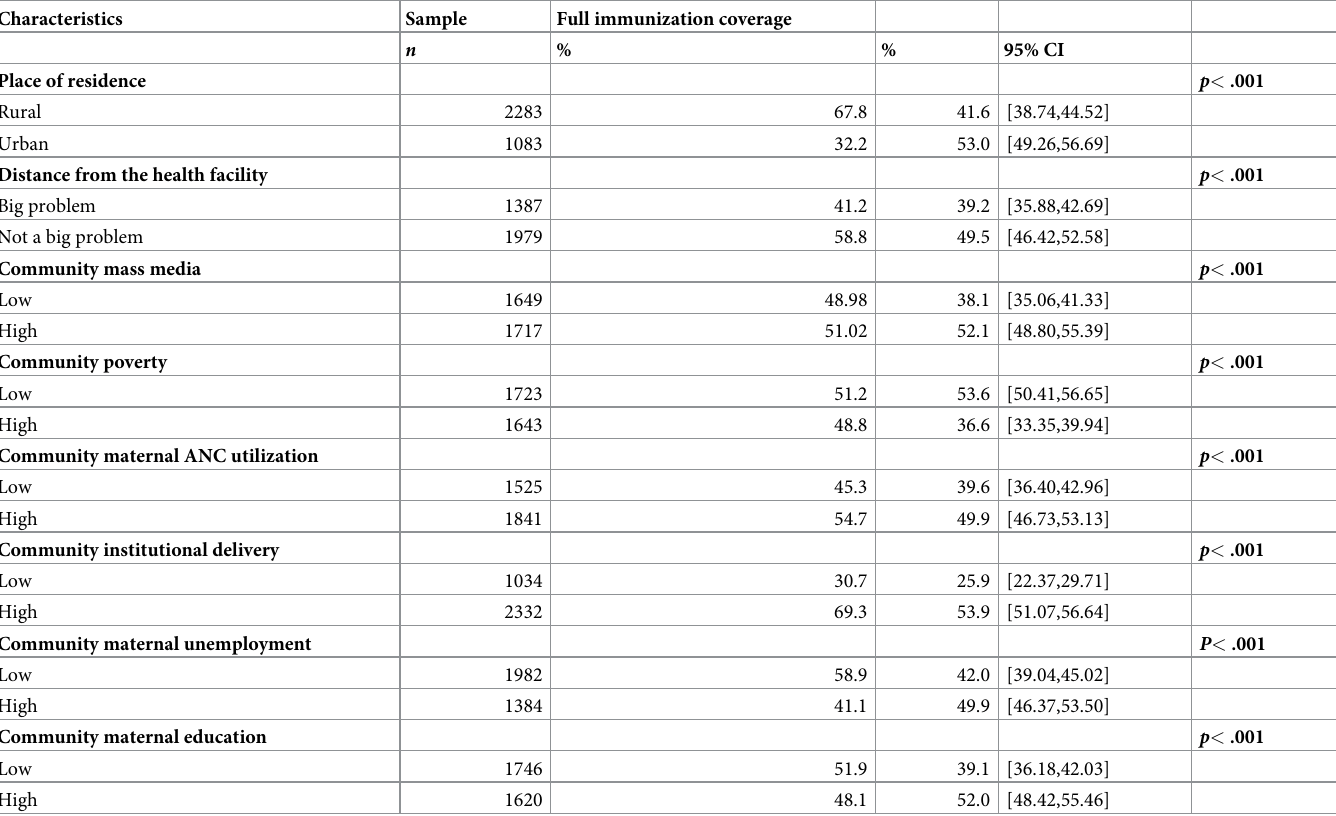
Table 3. Immunization coverage among 12–23-month-old children according to their contextual (community-level) background characteristics in the DRC in 2013–14 ( n = 3,366).